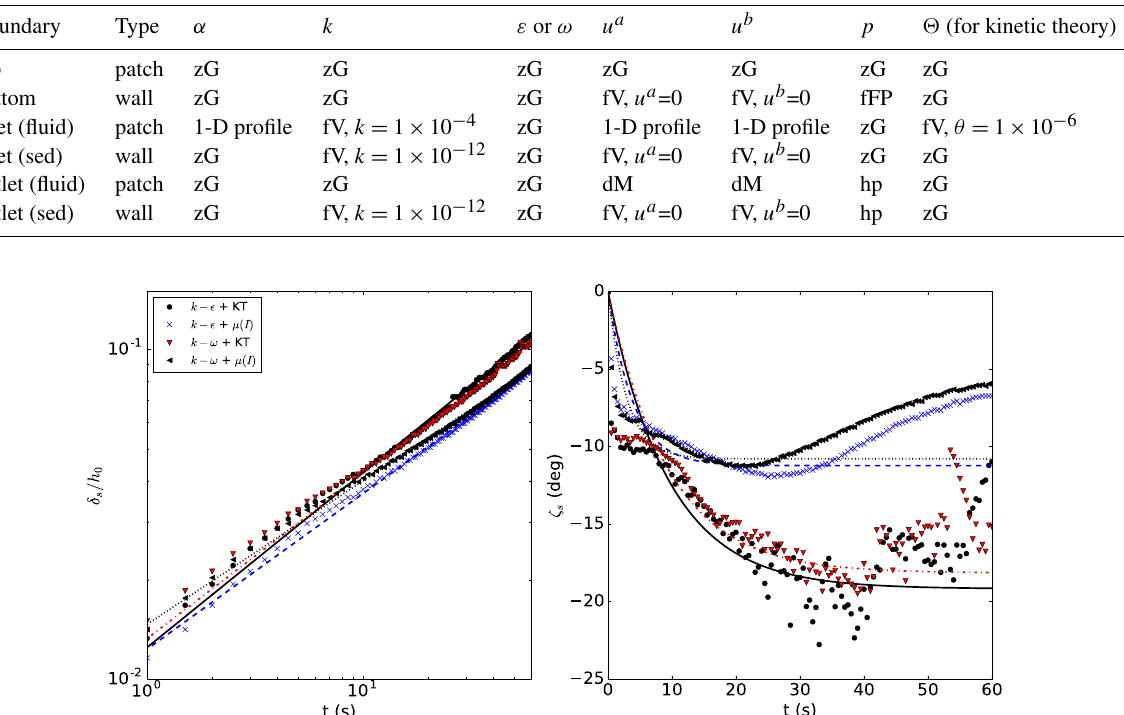
Table 10. Summary of the boundary conditions implemented in the 2-D scour downstream of an apron configuration. The following abbrevia- tions are used: zG is zeroGradient for Neumann boundary condition, fV is fixedValue for Dirichlet boundary conditions, dM is directionMixed for mixed Dirichlet–Neumann boundary conditions, fFP is fixedFluxPressure corresponds to a Neumann boundary condition for the pressure gradient, and hp for Dirichlet boundary condition using the hydrostatic pressure.